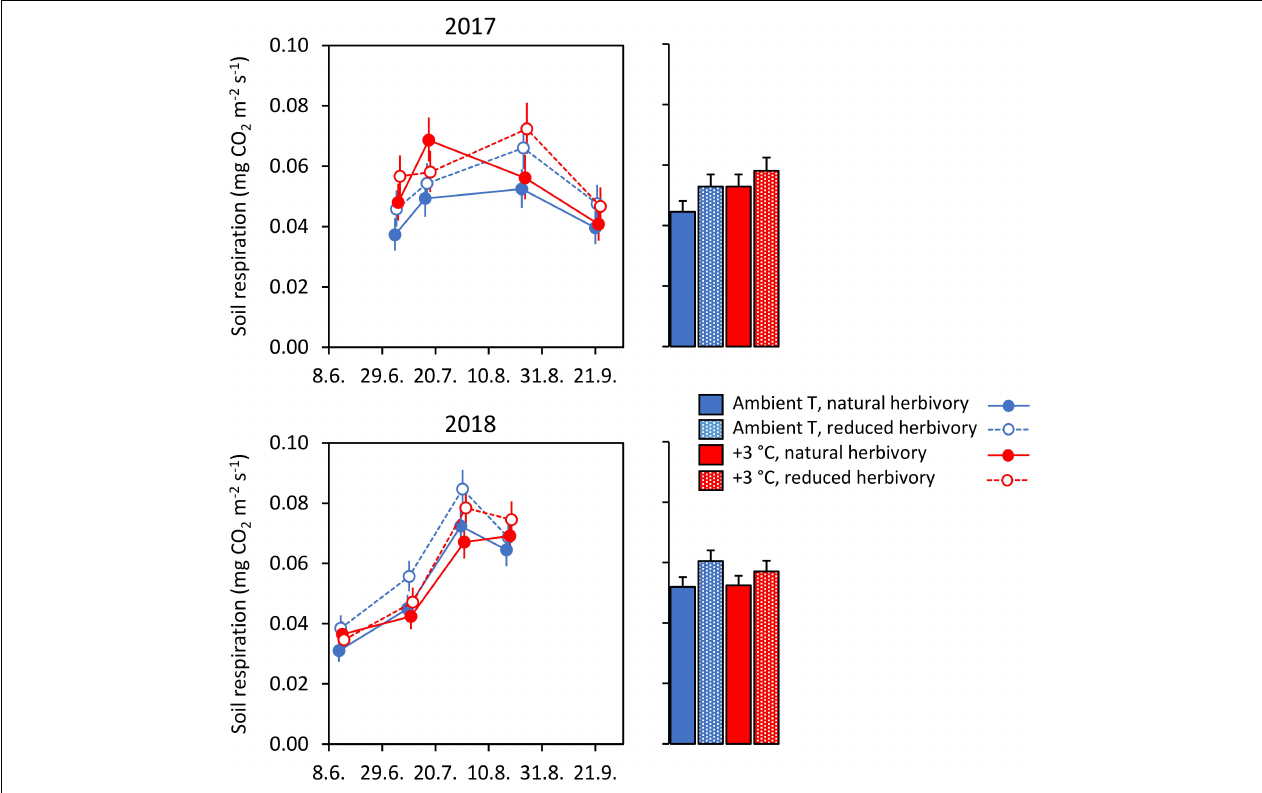
FIGURE 5 | In situ soil respiration under Subarctic field layer vegetation growing in ambient or +3 ◦ C temperature and with either natural or reduced insect herbivory in 2017 and 2018 with seasonal means on right hand panels. The means and errors are estimated marginal means and SE values ( n = 5) produced by fitted statistical models and were back-transformed from square root-transformed